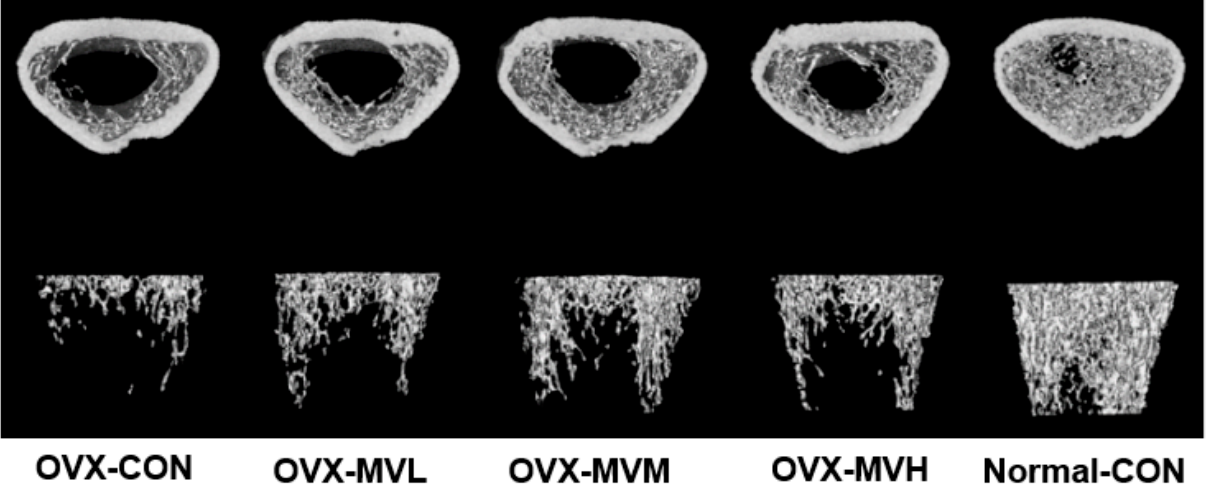
Figure 1. Bone mineral density (BMD)-related parameters after 12-week treatment of mulberry vin-